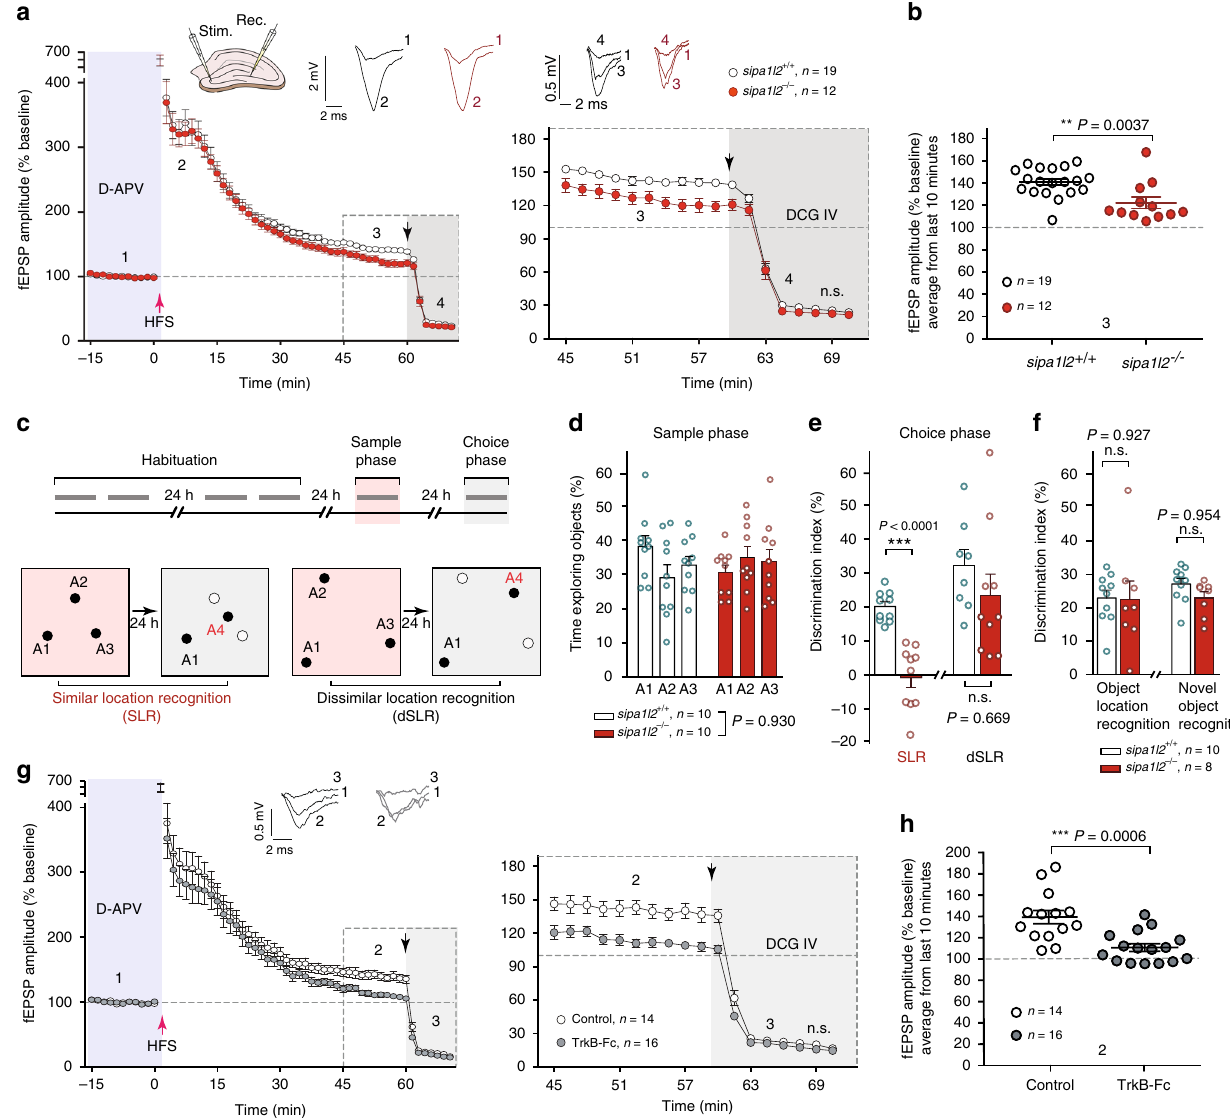
Fig. 1 sipa1l2 − / − mice exhibit impaired MF plasticity and de fi cits in pattern separation. a MF-LTP was induced in acute slices using a high-frequency stimulus (HFS) protocol. The NMDA receptor antagonist D-APV (50 μ M) was present during baseline recordings and LTP induction (shaded blue). Bath application of the group II mGluR agonist DCG-IV (2 μ M) that suppresses synaptic transmission at the MF pathway was performed during the last 10 min (shaded gray) of each experiment to control input speci fi city. Left, the average values of fEPSP amplitudes upon MF-LTP induction. Right, fEPSP amplitudes during the last 45 – 70 min following MF-LTP induction. b Averaged fEPSP amplitudes recorded during the last 10 min of a before DCG-IV application (Mann-Whitney U test). c Timeline (upper panel) and schematic representation of the object distribution (lower panel) of the spatial pattern separation test. Gray bars indicate 10-min intervals. During the sample phase (red-shaded) objects (A1 – 3) in the similar location recognition group (SLR) were placed closer while objects in the dissimilar location recognition group (dSLR) (A1 – 3) were placed farther away from each other. During choice phase (gray- shaded), a new object (A4) was introduced. Animals from the SLR fi nd A4 closer to positions A2 – A3 and have a higher demand for pattern separation than those from the dSLR. Filled circles (A1 – 4) represent object location. Open circles indicate the absence of objects. d Exploration time of sipa1l2 wt and ko animals in A1 – 3 during the sample phase (two-way ANOVA). e Discrimination index during choice phase in the SLR and dSLR groups (unpaired Student ’ s t test). f Discrimination index of sipa1l2 wt and ko animals during the novel object location recognition and object recognition test (unpaired Student ’ s t test). g , h Left, average fEPSP amplitudes upon MF-LTP induction performed as explained in a in control and BDNF-depleted slices (TrkB-Fc, 5 µ g/mL). Right, a close-up representation from the last 45 – 70 min. In h , averaged fEPSP amplitudes obtained during the last 10 min of g prior DCG-IV application (Mann- Whitney U test). Bars and error bars depict mean ± SEM in all graphs. Circles represent mean values from individual subjects ( d – f ) or slices ( a , b, g , h ). n.s. not signi fi cant. "**" indicates P ≤ 0.01; "***" indicates P ≤ 0.001. endosomes in axons requires Snapin, an adaptor protein that slices (Fig. 2m). Thus, interruption of the SIPA1L2-TrkB interaction recruits dynein by interacting with DIC 18 . However, whether in wt mice mimics the de fi cits of sipa1l2 − / − mice. Snapin directly or indirectly interacts with its cargo is still unclear. Heterologous coimmunoprecipitation experiments using tag- SIPA1L2 interacts with Snapin and enables TrkB traf fi cking . speci fi c antibodies revealed that Snapin associates with the traf fi cking of TrkB-signaling NATURE COMMUNICATIONS| (2019) 10:5448